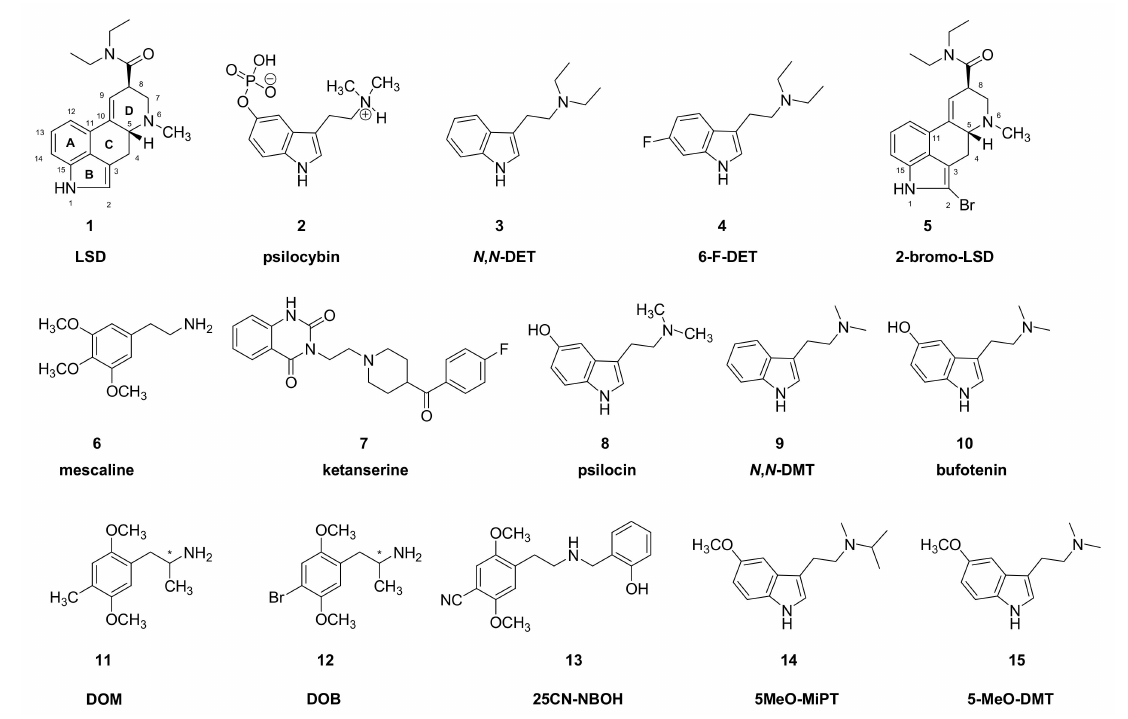
Figure 1. Chemical structures of LSD and some classic hallucinogenic compounds—(*) indicates chiral